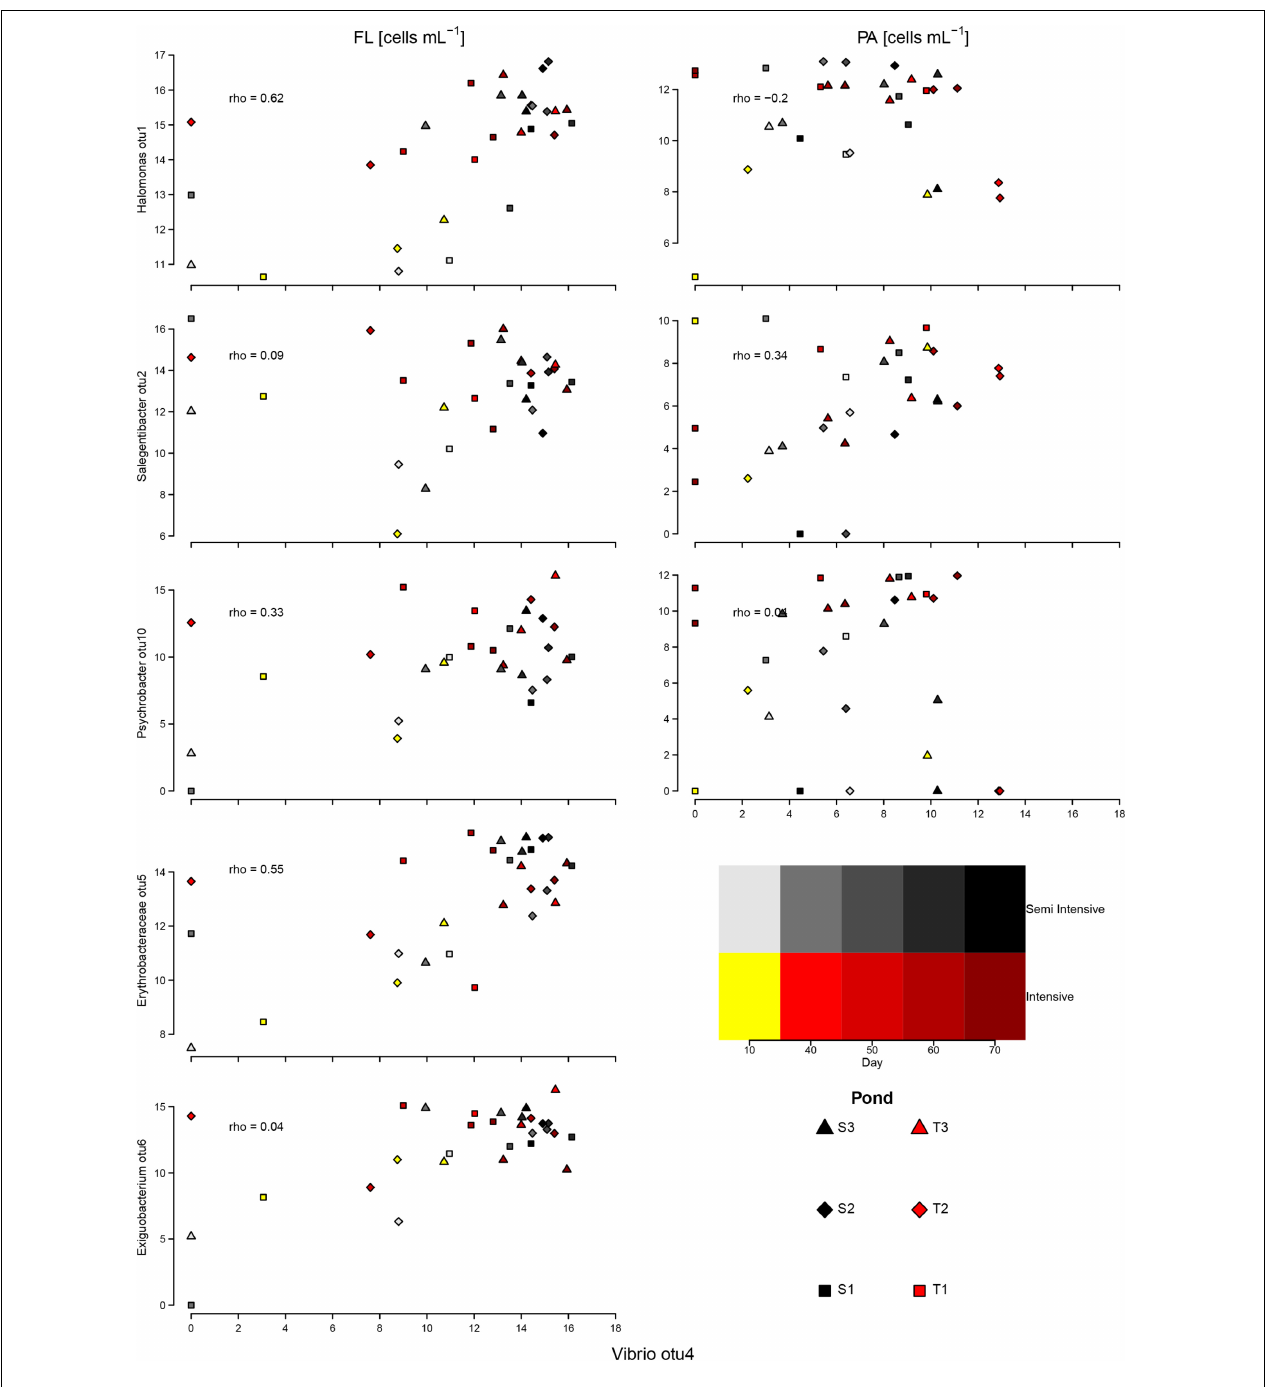
FIGURE 4 | Correlation between estimated proportion of cells of the most-abundant OTUs in the FL and PA fractions and the dominant Vibrio OTU. The axes show log-transformed estimated bacterial numbers. rho, Spearman correlation coefficient.